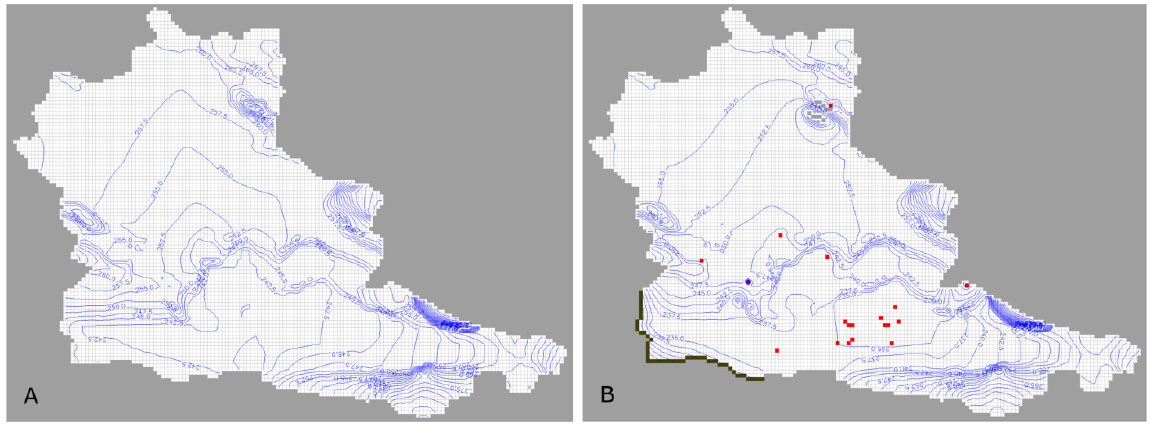
Figure 12. Hydrodynamic field distribution (blue lines—groundwater table contours in m a.s.l.) of the principal useful aquifer (Layer 3): variant 1—pseudo-natural state ( A ) and variant 2—groundwater resources prognosis ( B ).